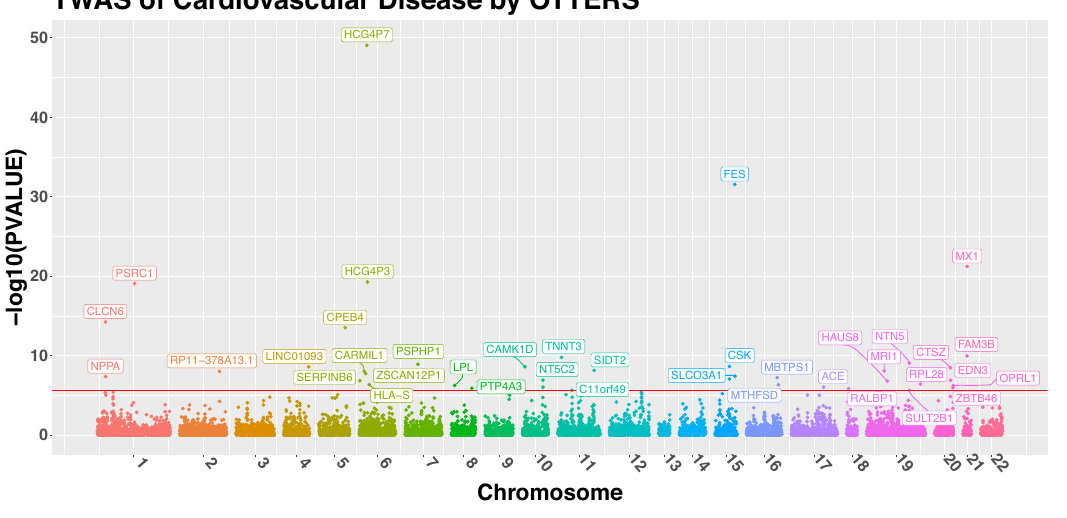
Fig. 4 | Manhattan plot of TWAS results by OTTERS. Manhattan plot of TWAS results by OTTERS using GWAS summary-level statistics of cardiovascular disease and imputation models fi tted based on eQTLGen summary statistics. The x -axis